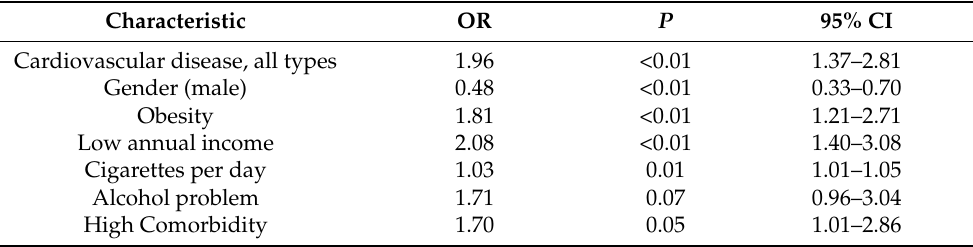
Table 3. Multivariate logistic regression: obstructive lung disease vs. CVD and potential confounders (N = 903).